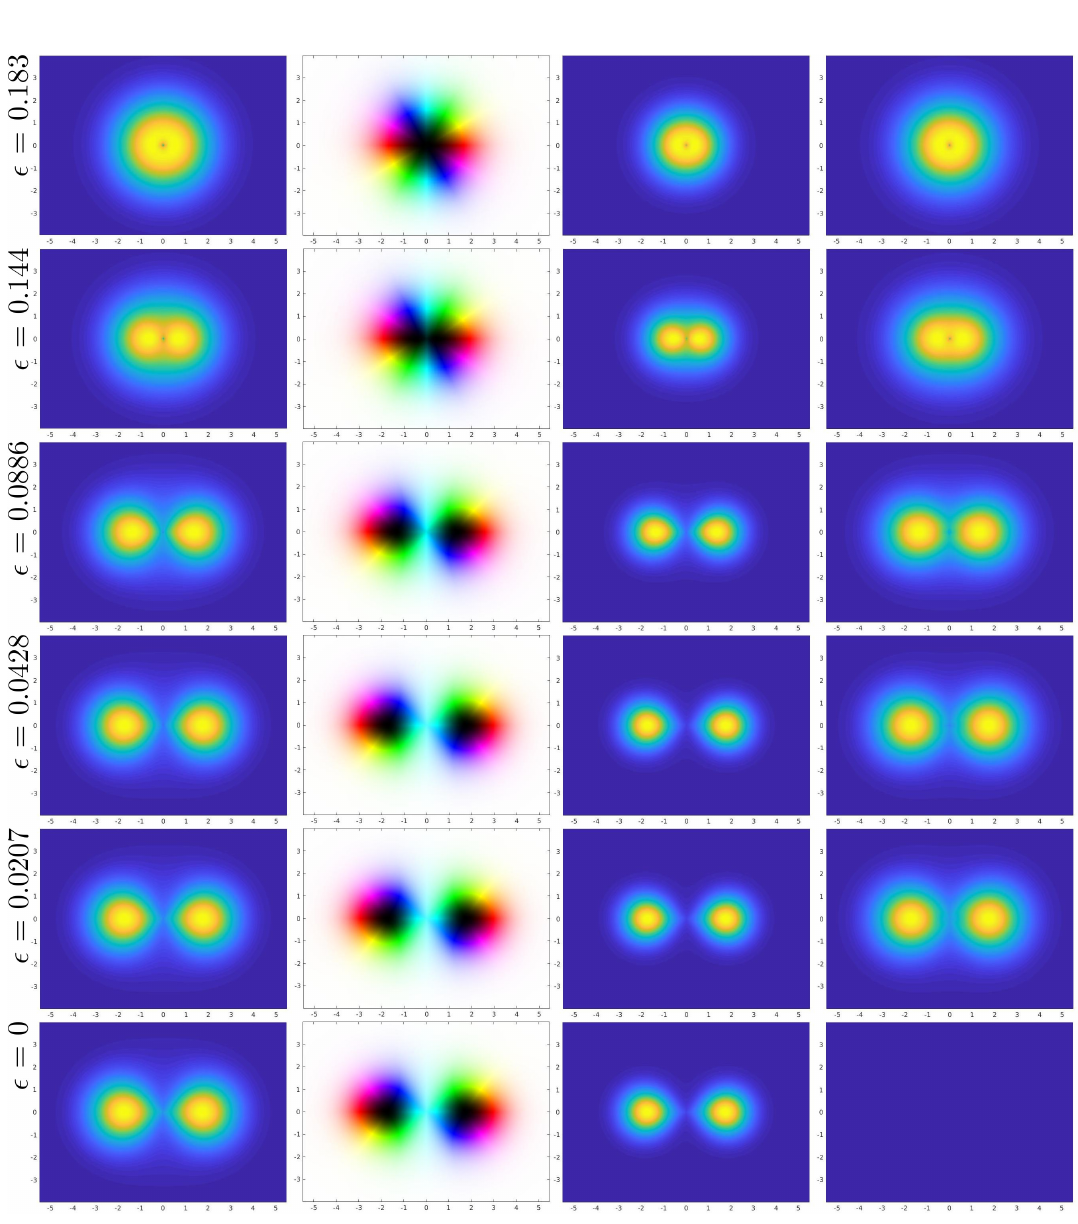
+ m 2 V 1 ) . The first row (i.e. for 2 1